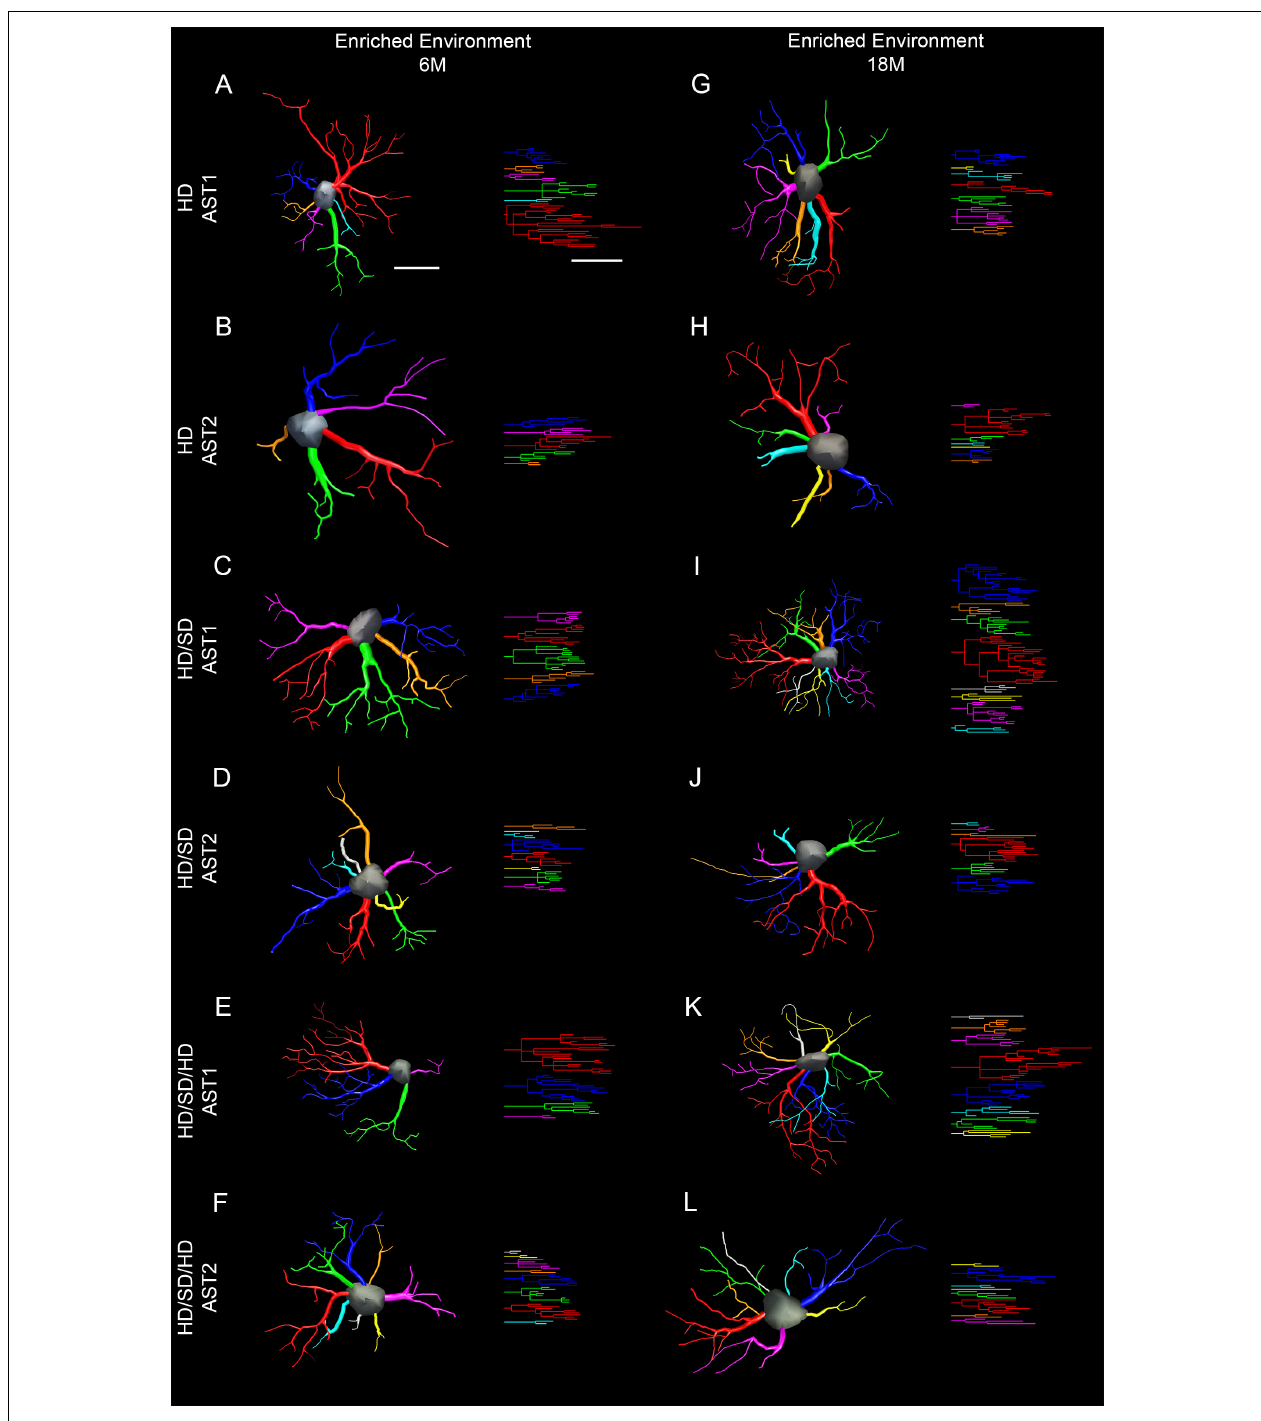
FIGURE 7 | Three-dimensional reconstruction of the morphological phenotypes of astrocytes located in the outer 1/3 of the molecular layer of dentate gyrus, in Mus musculus animals, and respective dendrograms of each astrocytic phenotype per experimental group maintained at enriched environment, reconstructed and analyzed through the Neuroexplorer software (MicroBrightField). To choose the representative cell of each group, the distance matrix was used to obtain the sum of the distances of each cell in relation to all the others. We considered the cell better representing each group as having at the least the sum of distances. Branches originating from the same parental trunk (primary branch) are shown with the same color. (A–F) 6M; (G–L) 18M. Cell bar = 15 µ m; dendrogram bar = 15 µ m. 6M, 6-month-old; 18M, 18-month-old; HD, hard diet/pellet; SD, soft diet/powder food; AST1, astrocyte with high morphological complexity; AST2, astrocyte with low morphological